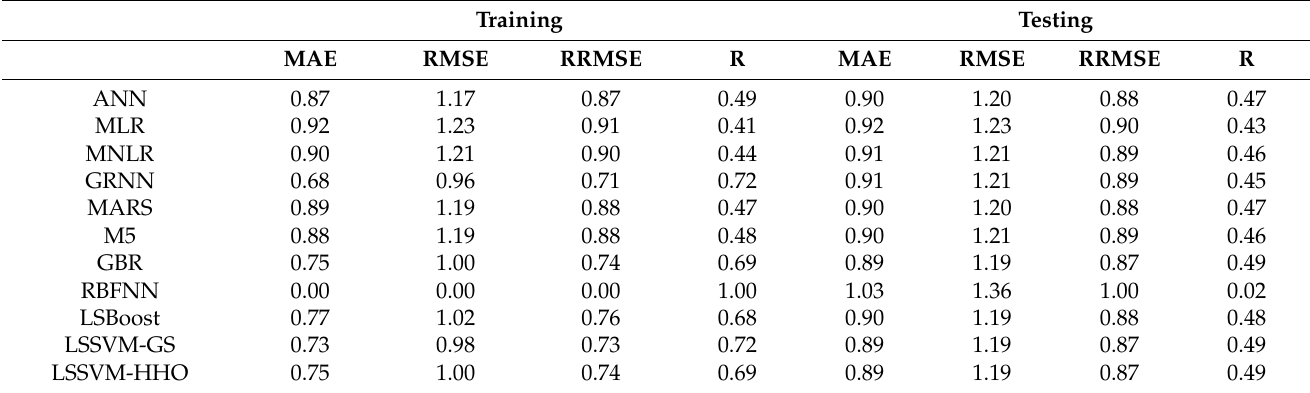
Table A9. Results of modeling WS with the base algorithms at the Birjand station. Training